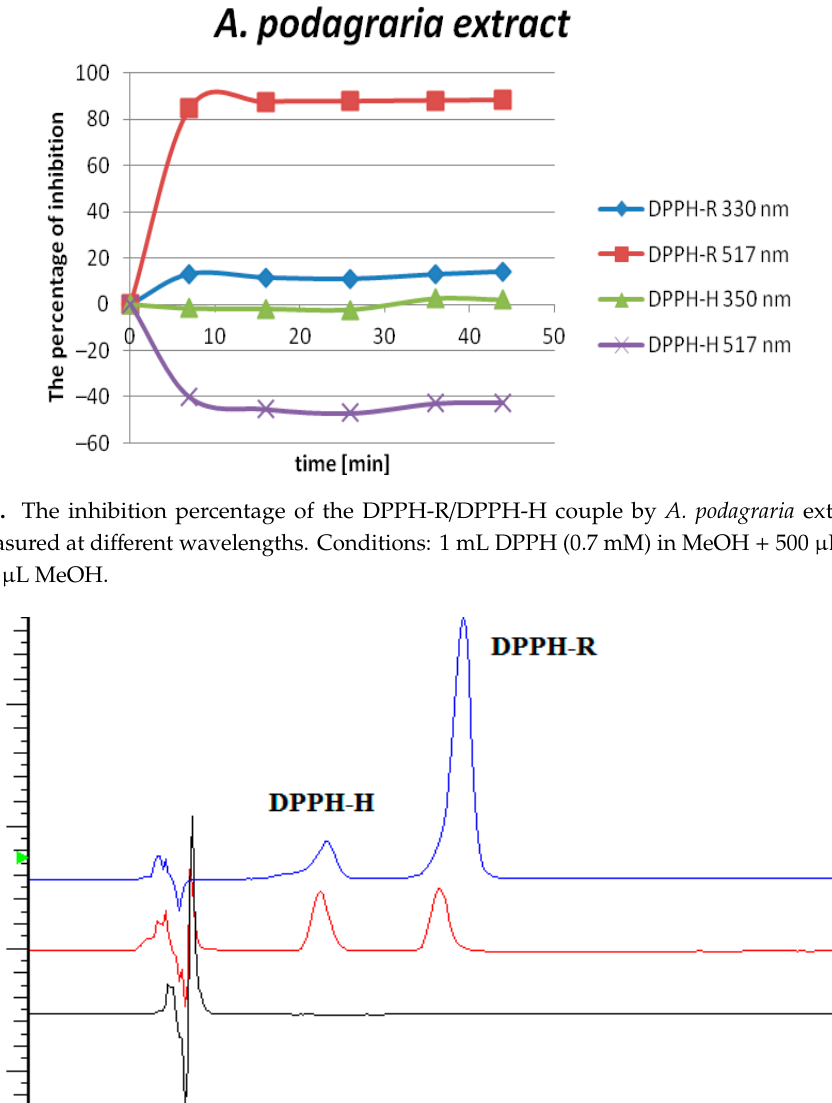
Table 4. The IC 50 of plant extracts estimation by DPPH-HPLC-DAD at 517 nm. DAD: diode array detector.